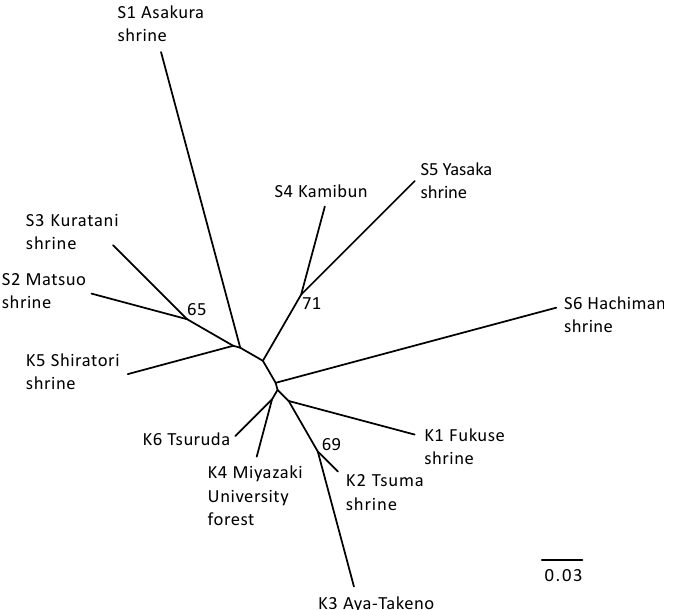
Figure 4. Neighbor-joining tree based on D A distances between populations of Q. hondae . Numbers indicate bootstrap values exceeding 50% based on 1000